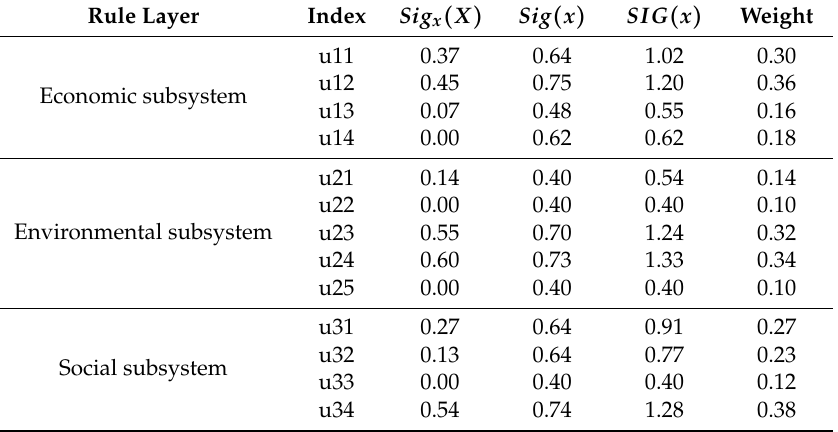
( X ) , Sig ( x ) , SIG ( x ) ), and weight. x